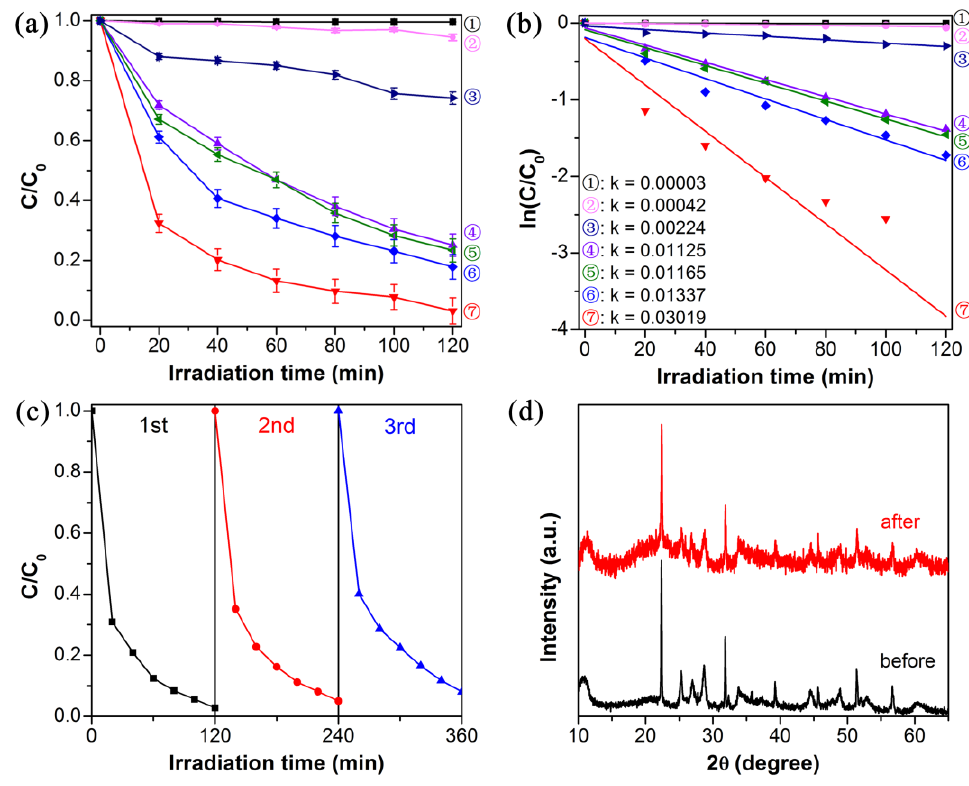
Figure 7. ( a ) Photocatalytic reduction efficiency and ( b ) pseudo first ‐ order kinetic fitting curves of aqueous Cr(VI) over ① no catalyst, ② NC ‐ 180, ③ mixture of CdIn 2 S 4 , In(OH) 3 and NiCr ‐ LDH, ④ aqueous Cr(VI) over 1 (cid:13) no catalyst, 2 (cid:13) NC-180, 3 (cid:13) mixture of CdIn 2 S 4 , In(OH) 3 and NiCr-LDH, 4 (cid:13) CIS- CIS ‐ 4, ⑤ HP ‐ 180 ‐ 2, ⑥ HP ‐ 180 ‐ 1, and ⑦ HP ‐ 180. ( c ) recyclability experiment of Cr(VI) photoreduc ‐ 4, 5 (cid:13) HP-180-2, 6 (cid:13) HP-180-1, and 7 (cid:13) HP-180. ( c ) recyclability experiment of Cr(VI) photoreduction tion over HP ‐ 180; and ( d ) XRD curves of HP ‐ 180 before and after stability test. over HP-180; and ( d ) XRD curves of HP-180 before and after stability